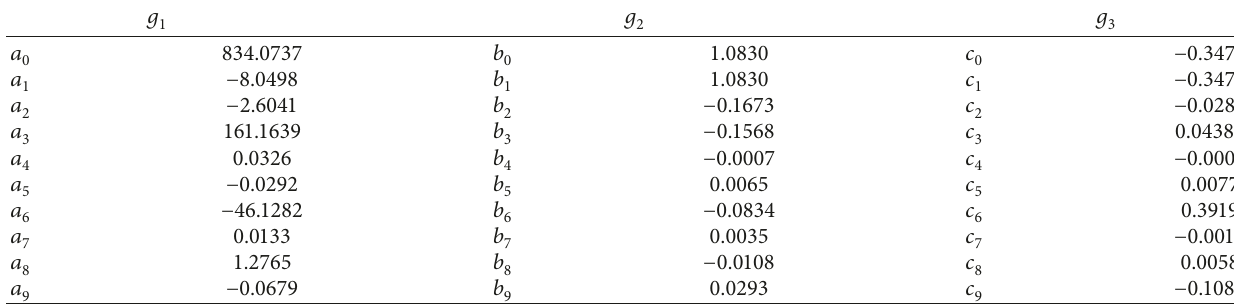
Table 9: Fitting coefficients for response surface functions.